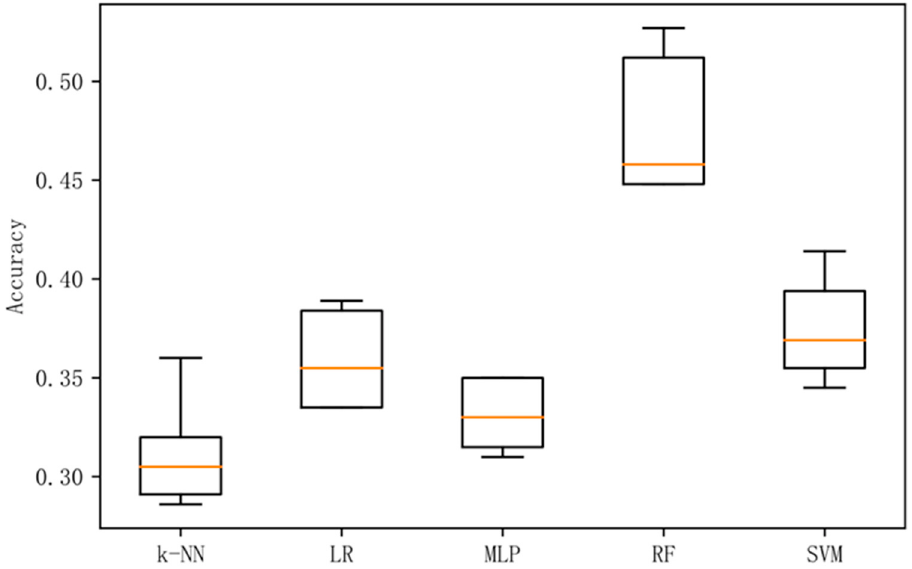
Figure 2. Accuracy in original dataset with five methods.